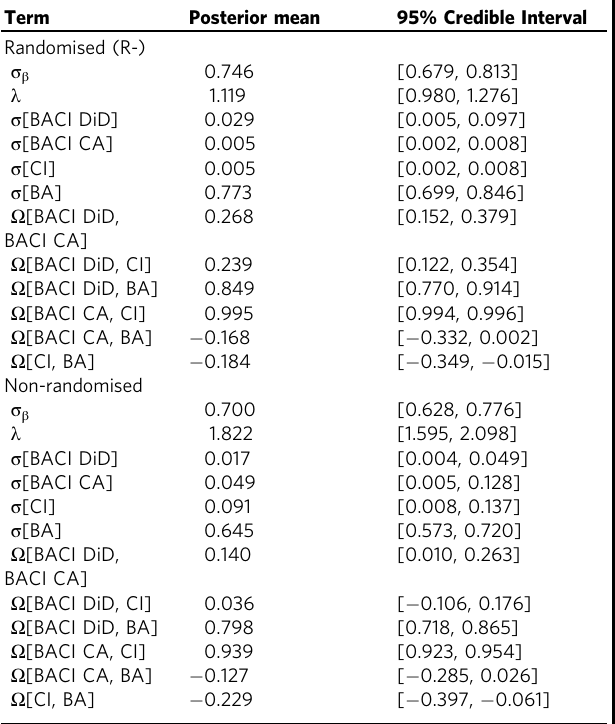
Table 2 Results of hierarchical Bayesian model for randomised and non-randomised